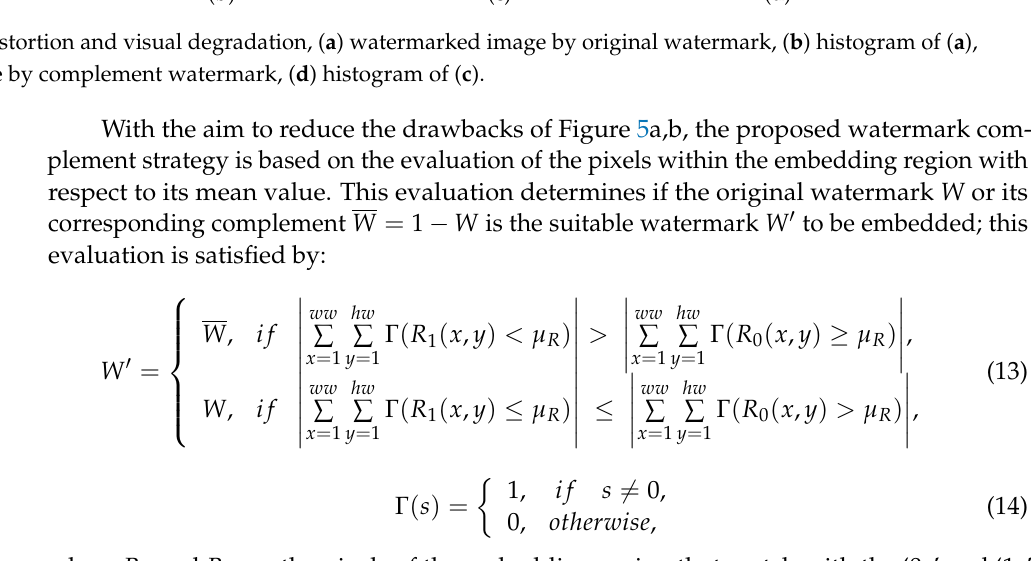
( d ) Figure 5. Histogram distortion and visual degradation, ( a ) watermarked image by original watermark, ( b ) histogram of ( a ), ( c ) watermarked image by complement watermark, ( d ) histogram of ( c ). According to the proposed strategy, an embedding error ( EE ) measurement is ob- tained; it considers all the pixels in the ranges (0 , µ R -1) and (µ R , 255) where the ‘0s’ and ‘1s’ of the watermark were embedded, respectively, as given by (15).